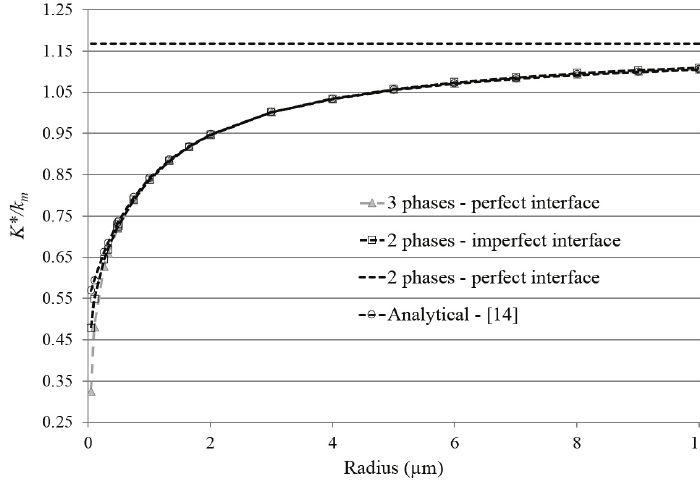
Figure 10. Variation of the effective thermal conductivity with the fiber